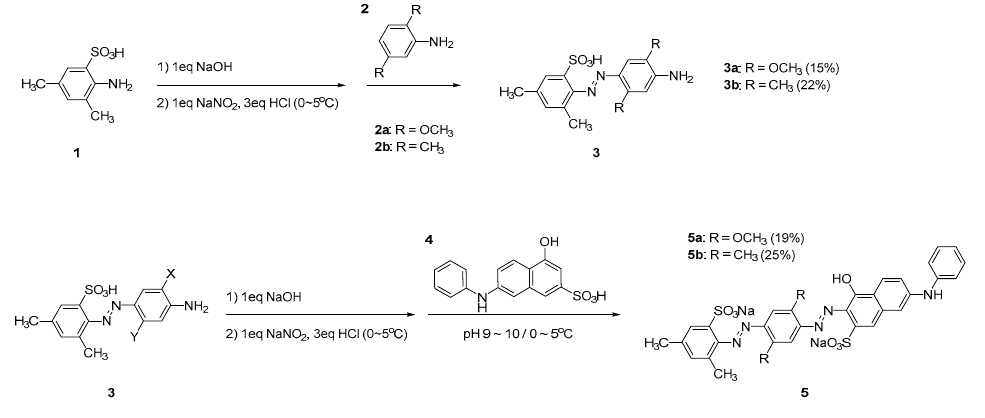
Figure 2. Synthesis procedure of two vapochromic dyes.